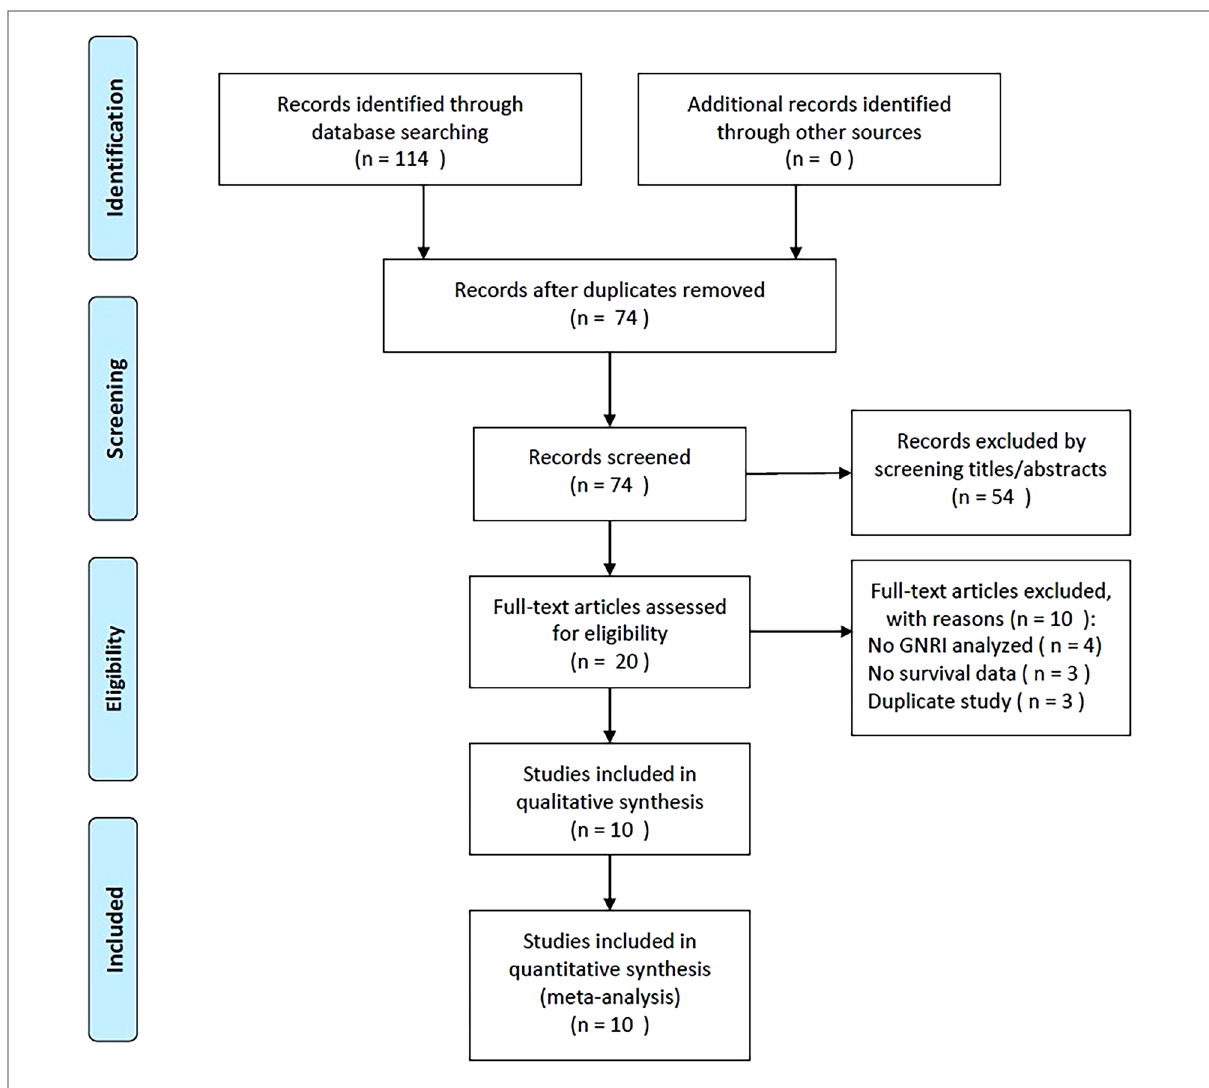
FIGURE 1 Flow chart of literature retrieval and research